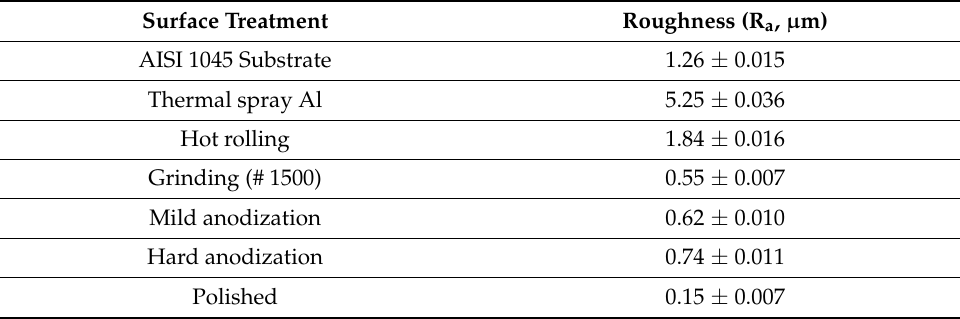
Table 1. Surface roughness of AISI 1045 steel after various surface